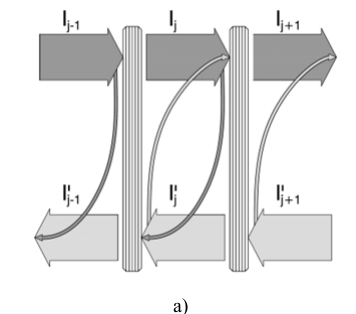
Fig. 2 a) Scheme of the optical Model and b)